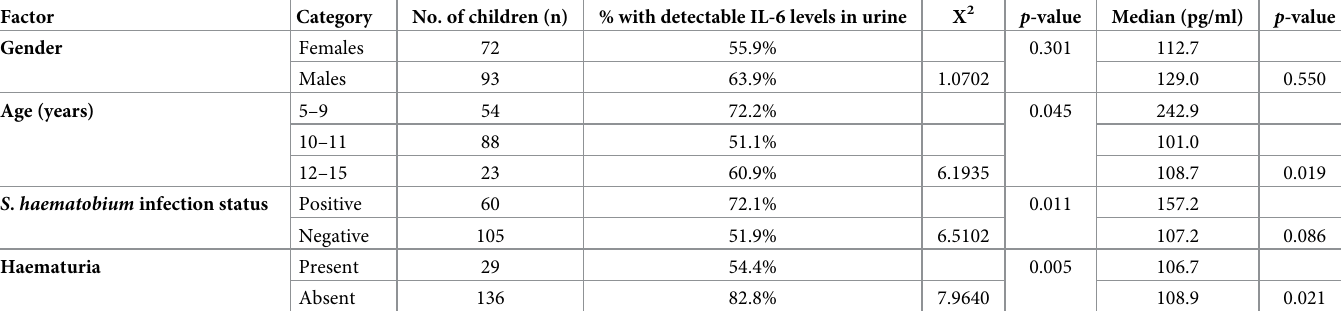
Table 3. Association between IL-6 and gender, age, S . haematobium infection status, and haematuria. Factor